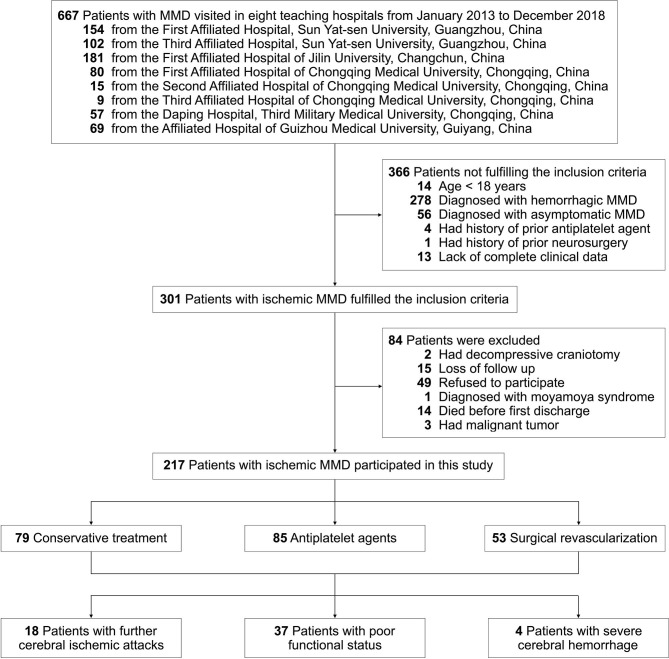
Flow chart presenting the process and outcome of this study.